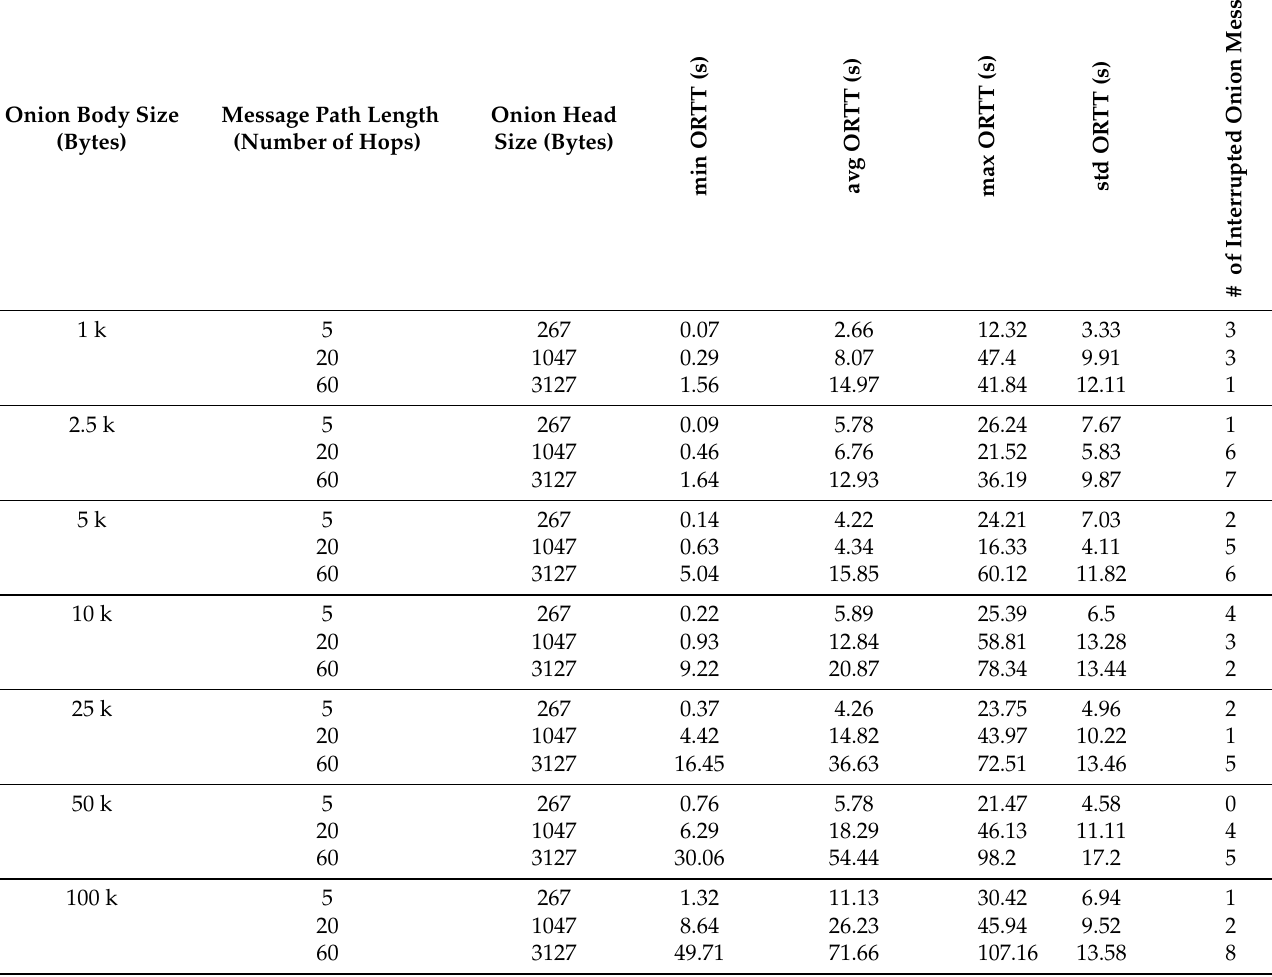
Table 4. Summary statistics of onion message